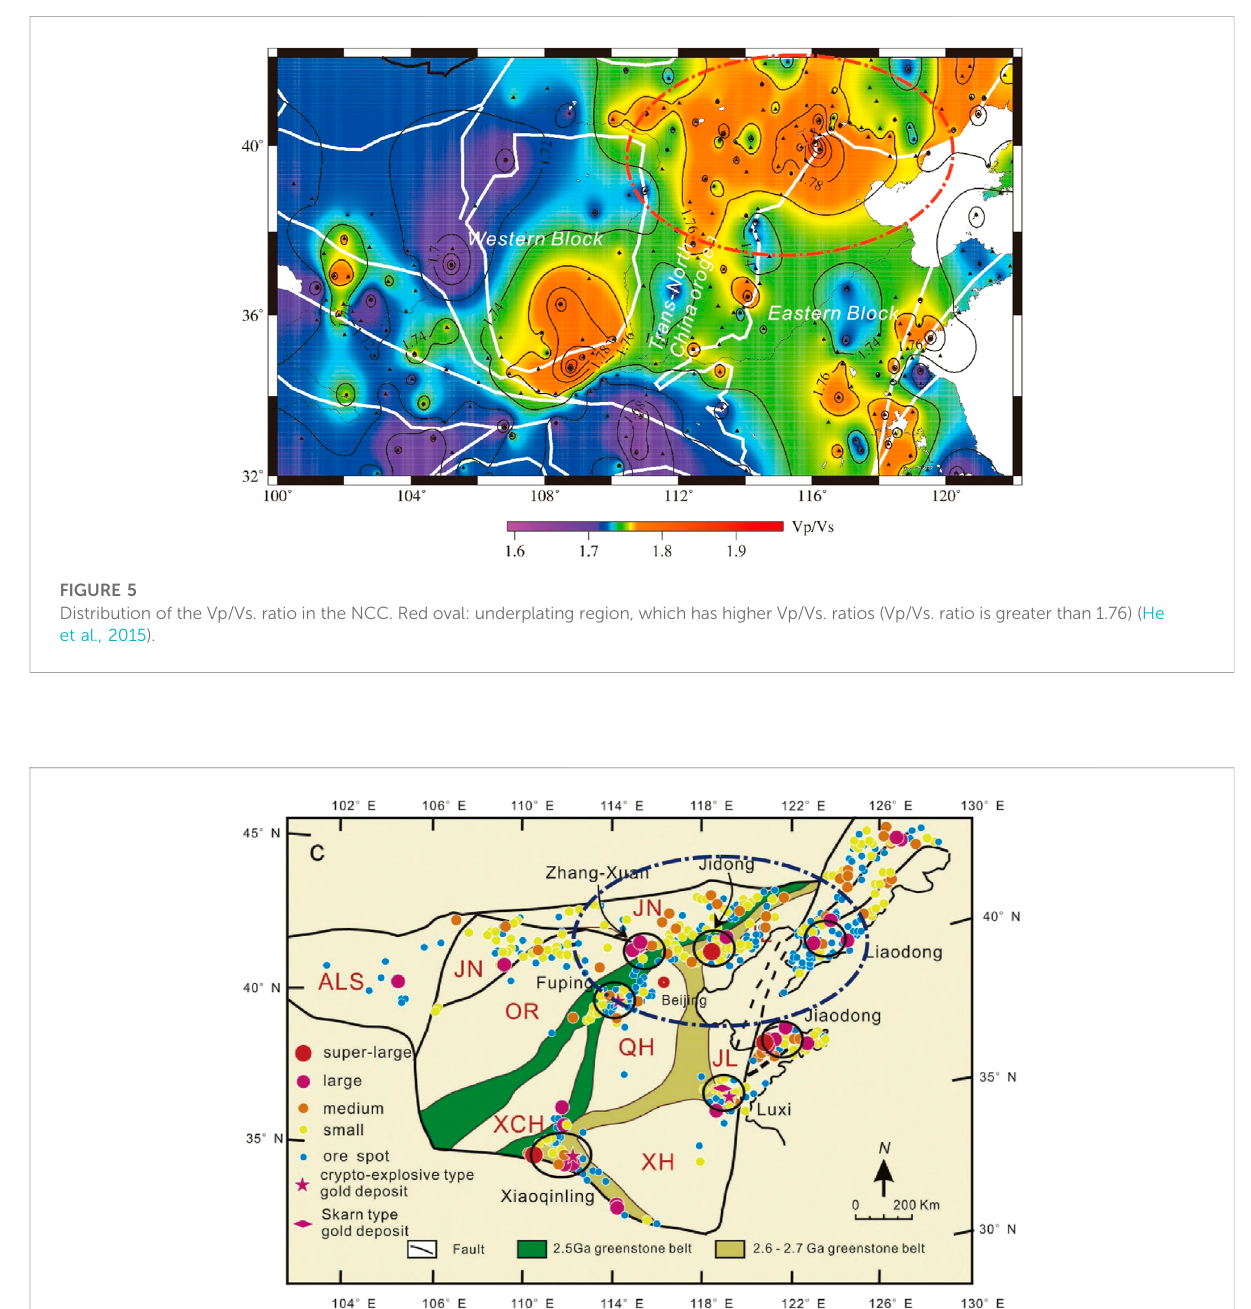
crust (e.g., Saunders et al. 2018) or surface (Figure 4), causing ultrama fi c/ma fi c lower crust and increasing Vp/Vs. ratios. H-k stacking of receiver function analysis indicates ultrama fi c/ma fi c lower crust (Vp/Vs . > 1.76) in the northern part of the NCC (red oval region) (Figure 5) (He et al., 2015), which corresponds well to the location of the upwelling mantle plume (Figure 3B).